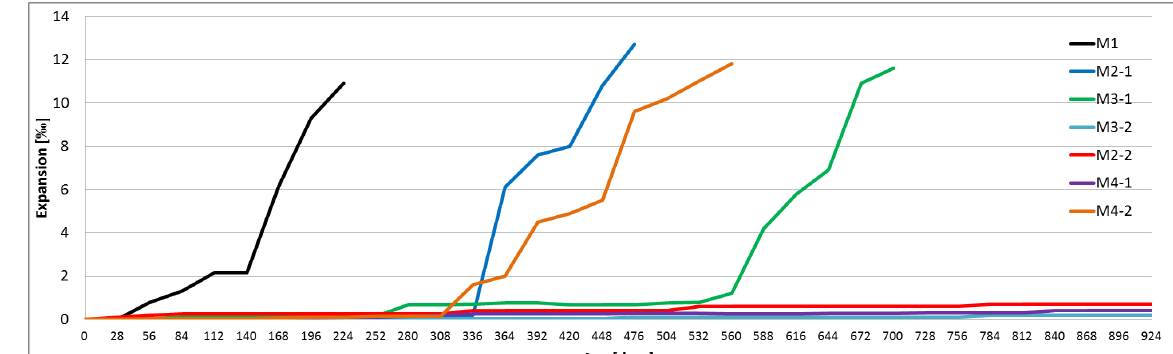
Figure 3: Expansion of mortars immersed in the 5% Na 2 SO 4 solution.